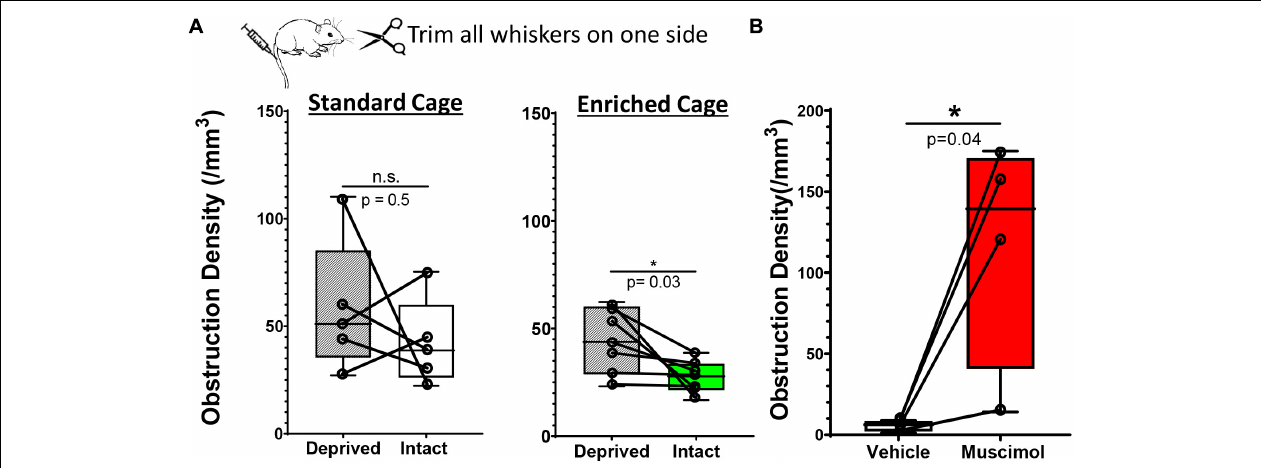
FIGURE 4 | Hemisphere specific changes in neural activity drive recanalization. (A) Whisker box plots show the density of microsphere obstructions in the sensory deprived and intact S1BF cortex in young adult mice subjected to unilateral whisker trimming. There was no significant difference between deprived and intact S1BF (somatosensory barrel field) in mice housed in standard cages [intact: 42.17 ± 20.37 obstructions/mm 3 vs. deprived S1BF: 42.17 ± 20.37 obstructions/mm 3 , paired t test, t ( 4 ) = 0.818, p = 0.46, n = 5 mice/group]. However, mice exposed to an enriched environment showed a significant reduction in the intact S1BF (27.22 ± 7.63 obstructions/mm 3 ) compared to the deprived S1BF [44.42 ± 15.25 obstructions/mm 3 , paired t test t ( 6 ) = 2.66, p = 0.03; n = 7 mice/group]. (B) Plots show the density of microsphere obstructions in vehicle or muscimol injected hemisphere of young adult mice exposed to an enriched environment. Data are mean ± standard deviation. * p <